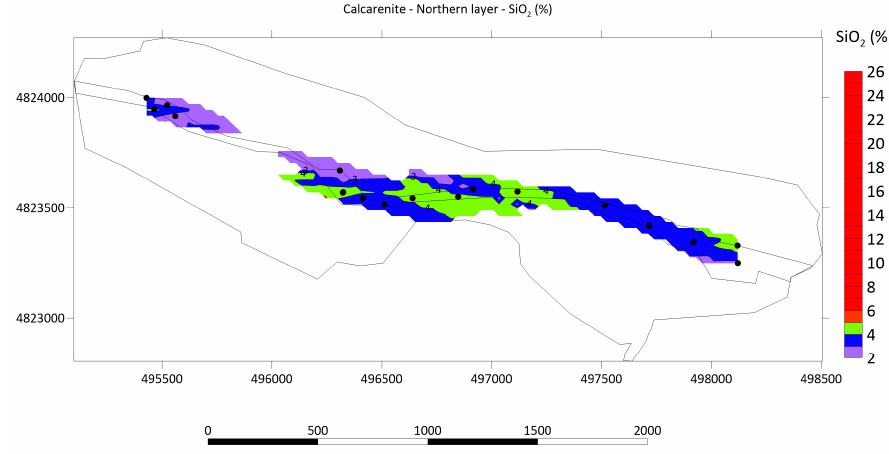
Figure 12. Map of CaO (%) in unit (5), northern layer (boreholes are black dots).